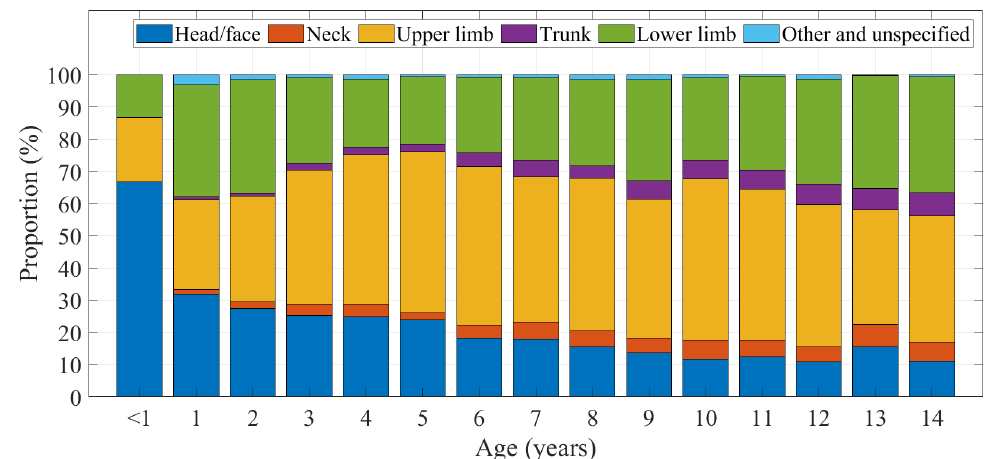
Figure 8. Injured body region by age.